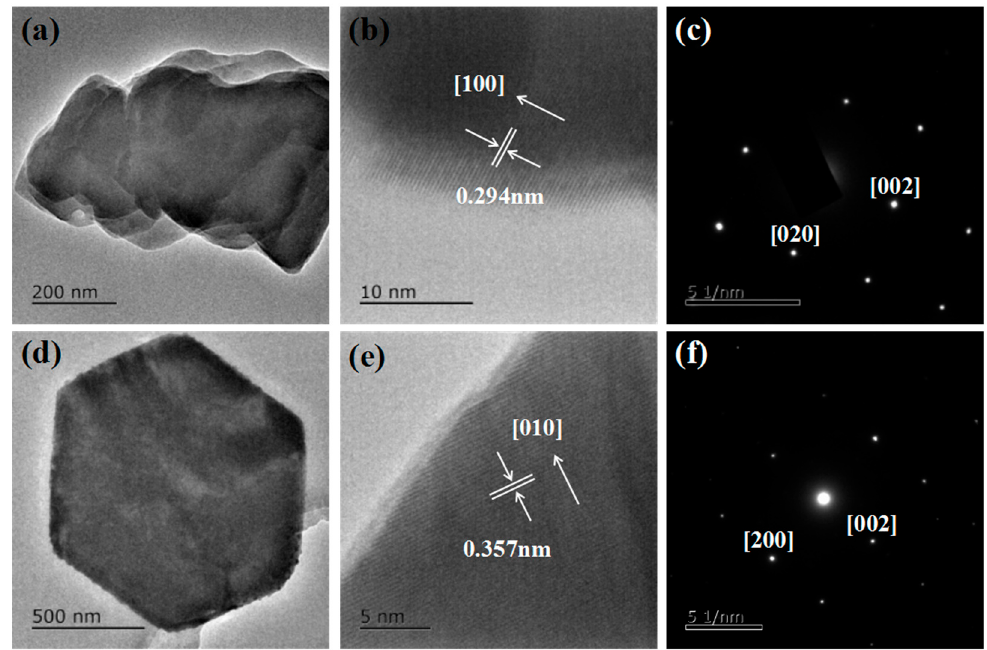
Figure 5. ( a ) The bright field TEM images, ( b ) HR-TEM images and ( c ) Selected area electron diffraction (SAED) pattern of the perovskite (C 6 H 5 CH 2 NH 3 ) 2 PbBr 4 nanosheets; ( d ) the bright field TEM images, ( e ) HR-TEM images and ( f ) SAED pattern of the perovskite (C 6 H 5 CH 2 NH 3 ) 2 PbI 4 nanosheets.